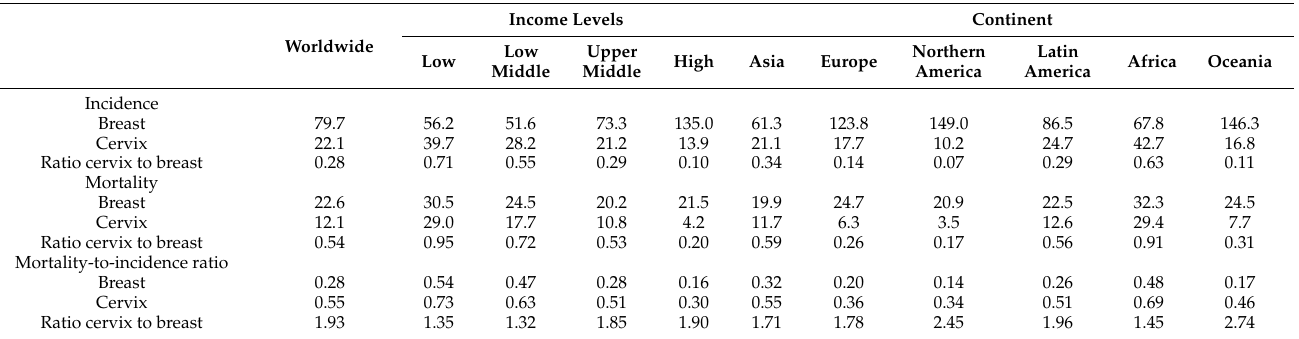
Table 2. Breast and cervical cancer epidemiology 2020, in ≥ 20-year-old females, age-standardized rates per 100,000